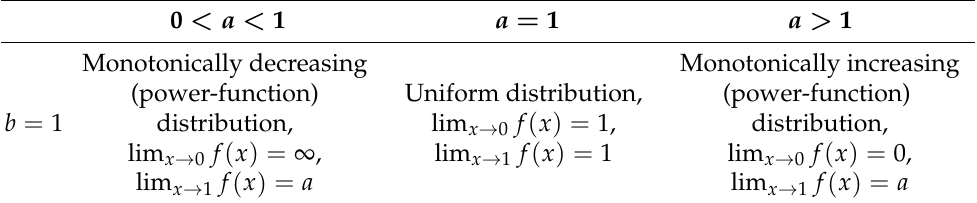
Table 1. Characteristics of the Kumaraswamy distribution for different parameter values